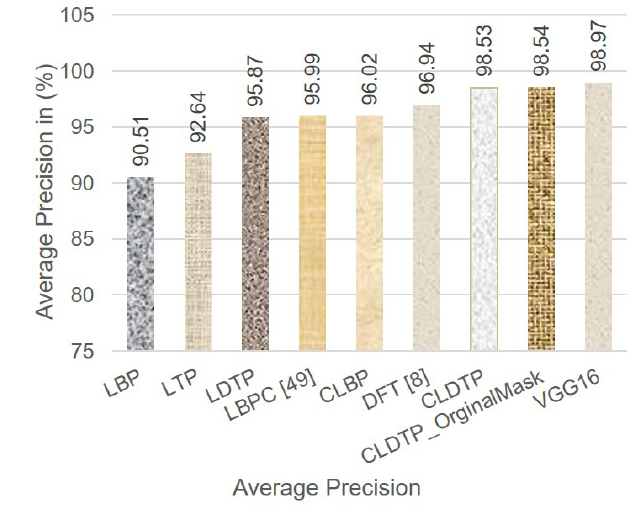
Figure 15. Average precision (AP) of spatial feature extraction APIs on the STAD